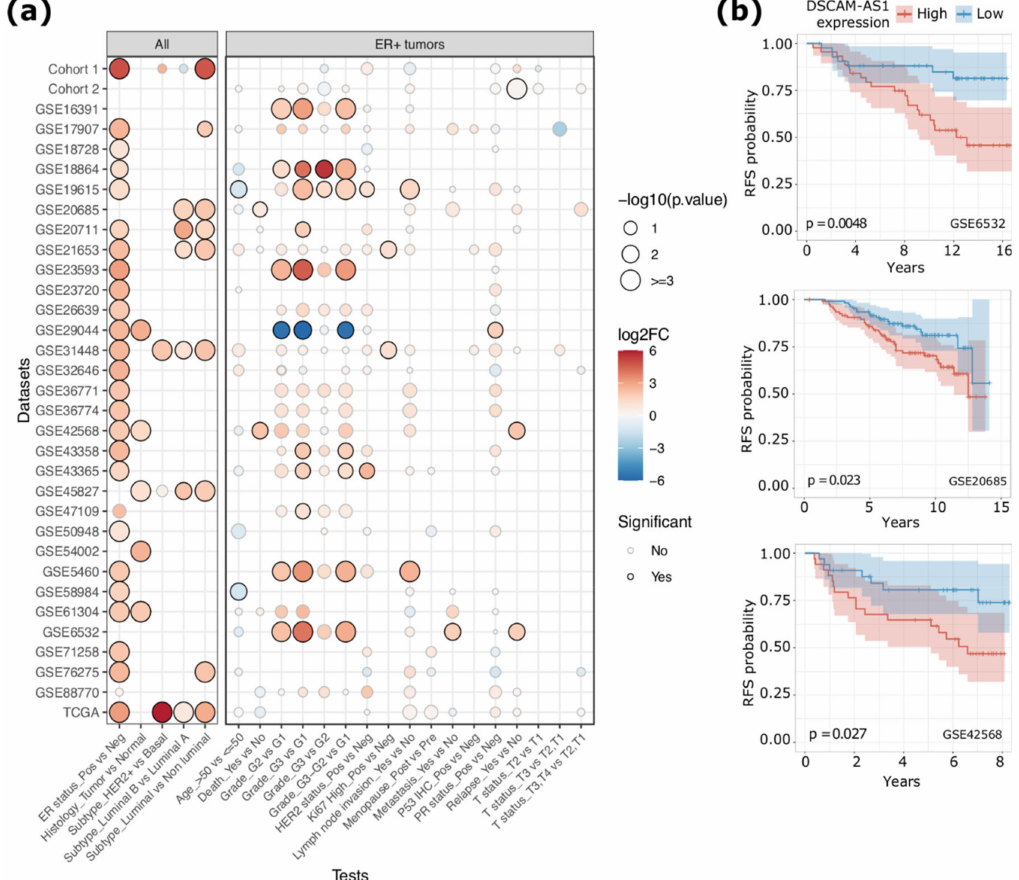
Figure 1. ( a ) Dot plot reporting the level of statistical significance of the di ff erential DSCAM-AS1 expression analyses between groups of Breast Carcinoma (BC) patients classified based on specific clinical data. The size of the dot is proportional to the significance of the results while the color code represents the log2FC of DSCAM-AS1 expression. The left panel reports the results obtained considering all the samples, while the right panel reports the results of tests performed considering only the ER + tumors. Estrogen Receptor (ER); positive (Pos); negative (Neg); Progesterone Receptor (PR). ( b ) Kaplan-Meier curves representing the Relapse Free Survival (RFS) of BC patients grouped by the median level of DSCAM-AS1 expression. p -value by log-rank